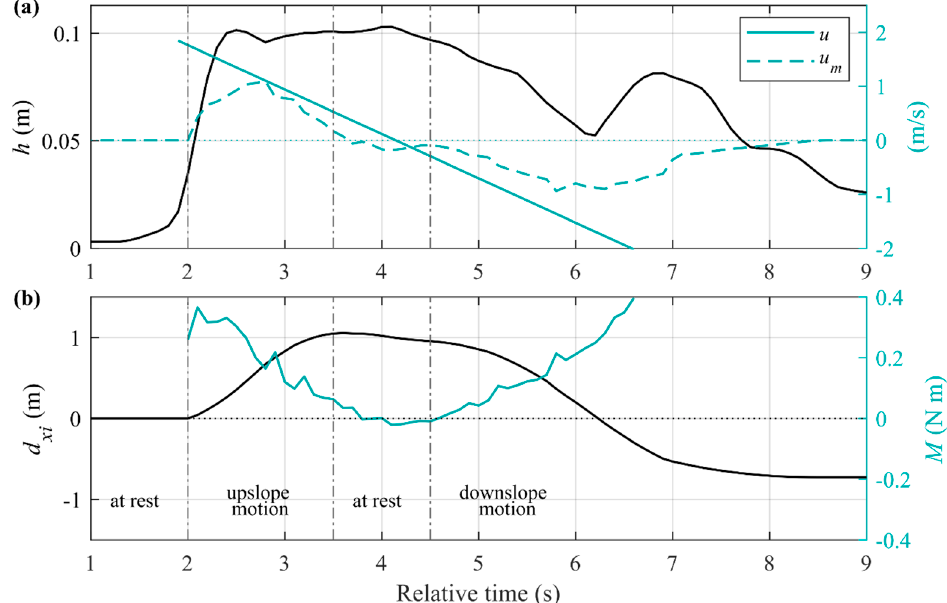
Figure 6. Example of hydrodynamics, object response, and moment for the AlP1B1 scenario. ( a ) Measured water depth, flow velocity and computed object velocity. ( b ) Measured object migration and estimated moment.